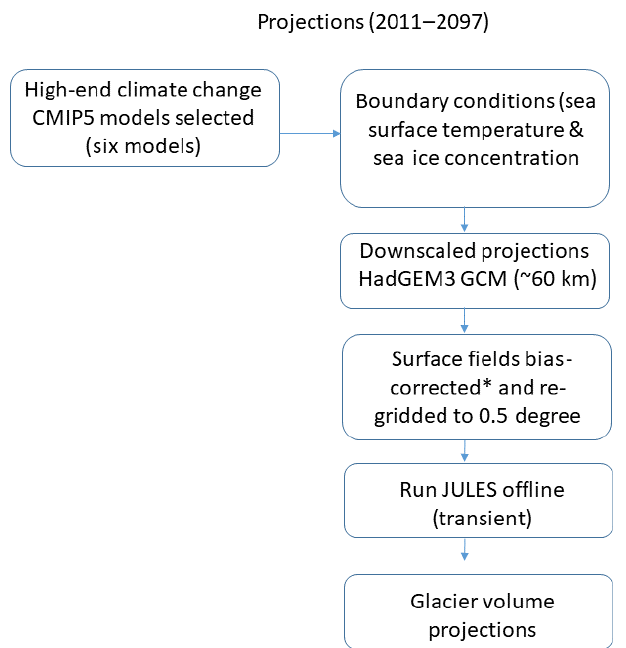
Figure 7. Flow chart showing the experimental setup to calculate future glacier volume. * The bias correction method is described by Hempel et al.